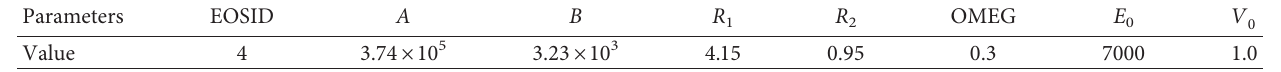
Table 10: Parameters of state equation of explosive.